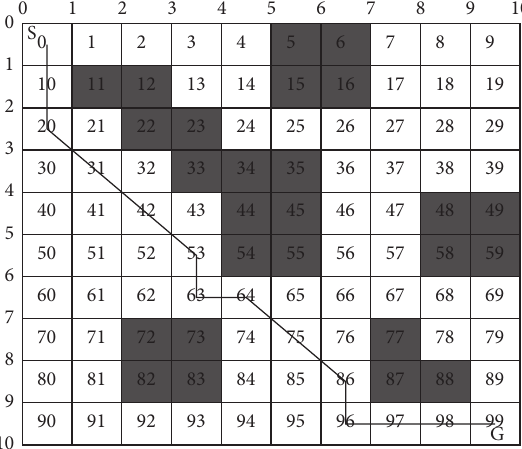
Figure 6: Path diagram after